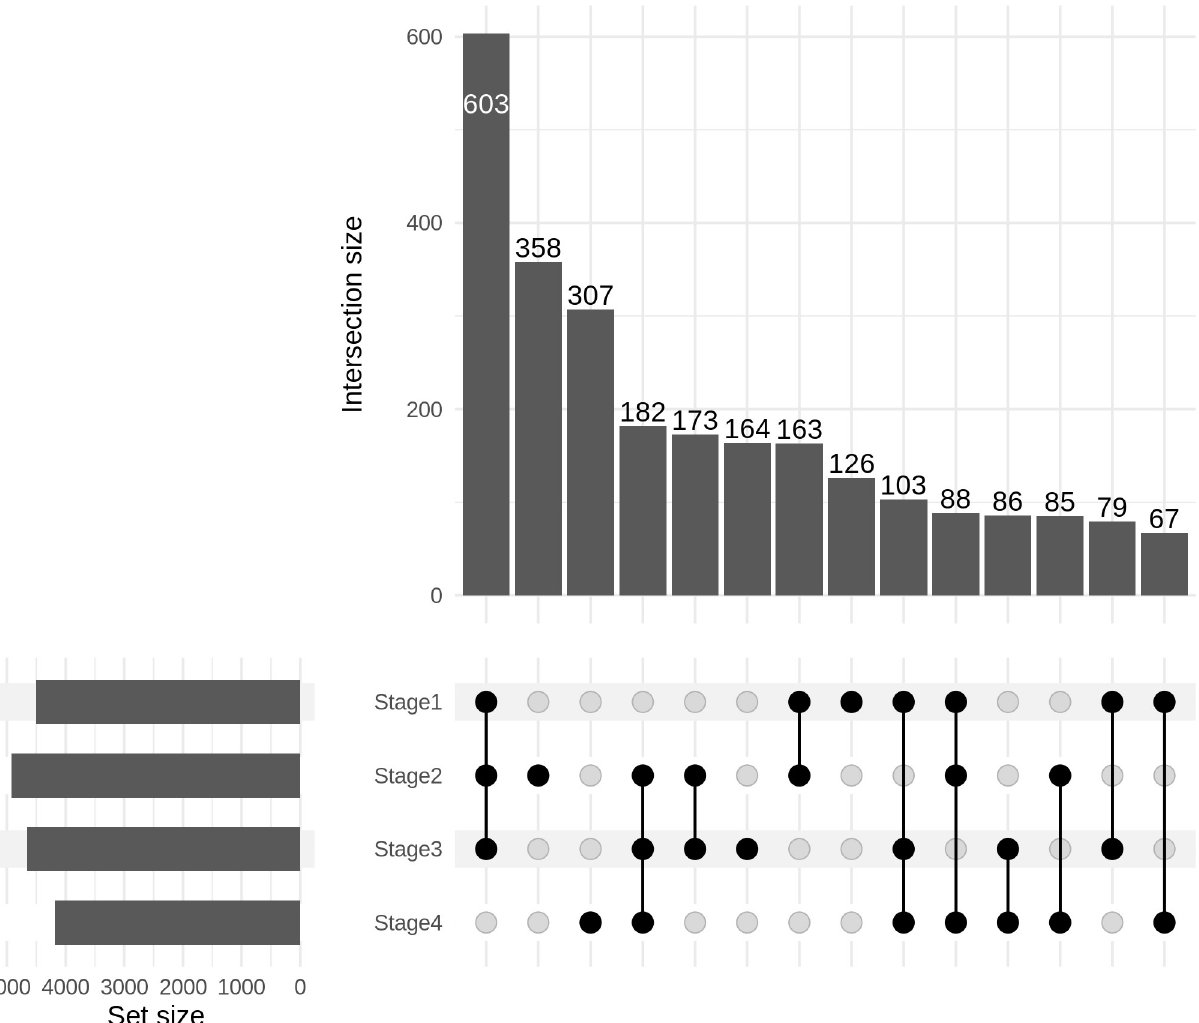
Fig 7. UpSet plot of BioMethyl-based stagewise gene expression modelling. The intersection of all stages yielded 3268 genes, which represent consistently differentially regulated genes.